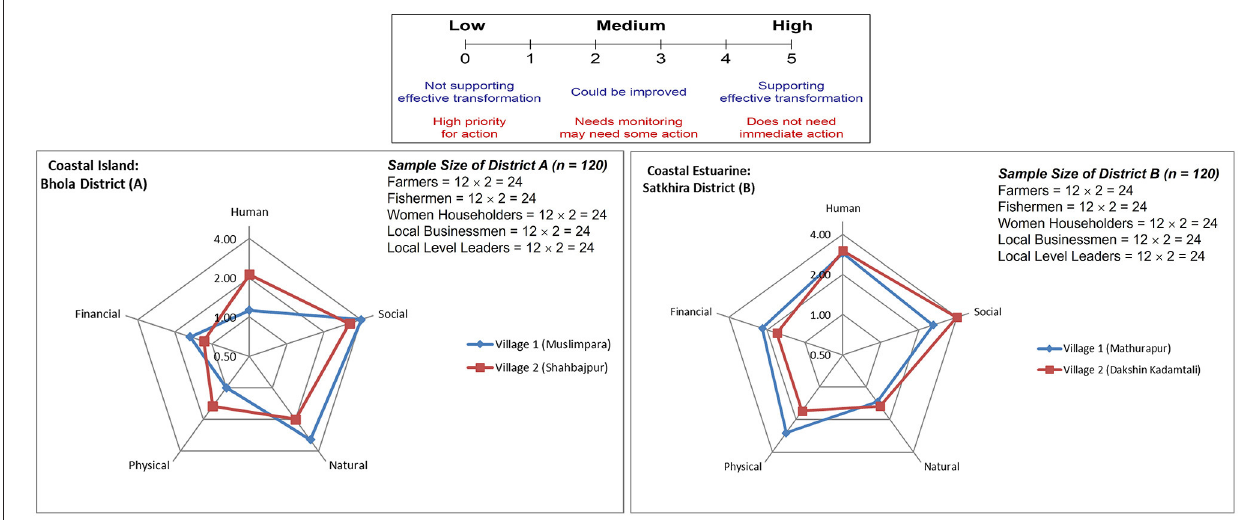
FIGURE 4 | Spider diagram showing the assessment of adaptive capacity of Bhola District (left) and Satkhira District (right) . The corresponding adaptive capacity measuring scale is shown on top (See also Table 1 ; Source: Nelson et al.,